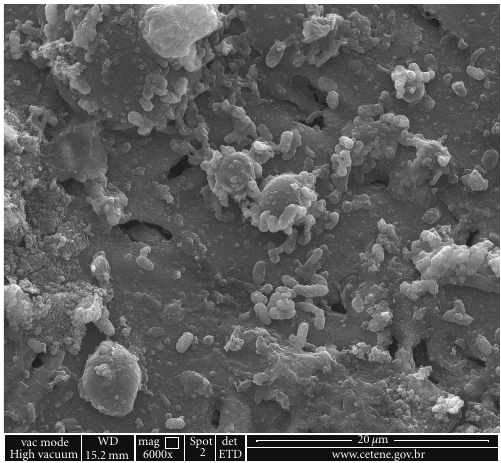
Figure 5: SEM of biofilms formed on AISI-1020 carbon steel, exposed to the fluid water + 30% B3 fuel for a period of 15 days.